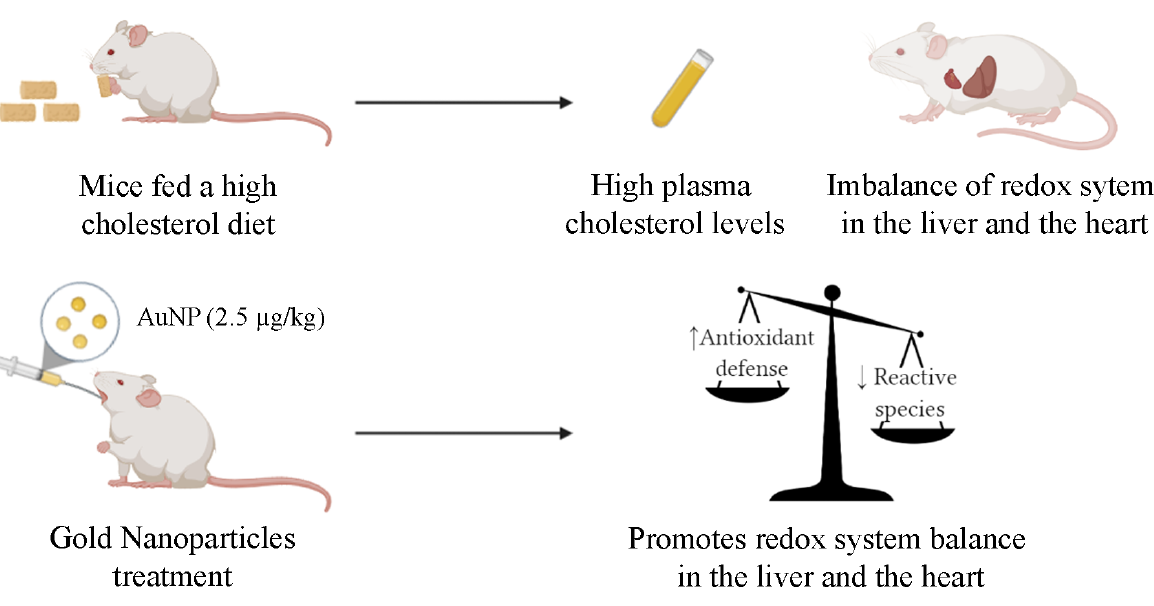
Figure 4. The illustration summarizes the effects of high cholesterol diet exposure and AuNP treatment on metabolic and oxidative stress parameters in the liver and heart of mice. Briefly, animals fed a high cholesterol diet exhibited high plasma cholesterol levels, i.e., hypercholesterolemia, which was not affected by AuNPs treatment. Also, hypercholesterolemia caused an imbalance of the redox system in the liver and the heart in a process that favors oxidative damage. AuNP treatment promoted redox system balance in both liver and heart, increasing antioxidant defense and reducing ROS